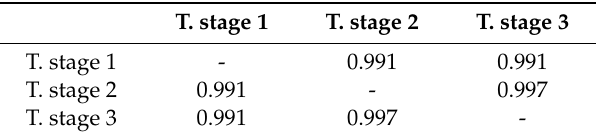
Table 5. Correlation matrices determined for air temperature values in all stages (Stages 1–3) during the initial 35 min of experiment.